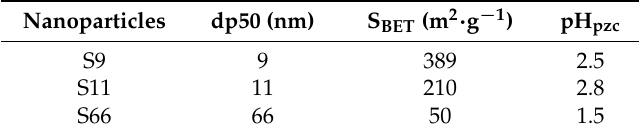
Table 1. Nanoparticles mean particle size (dp50), surface area (SBET) and isoelectric point (pHpzc).